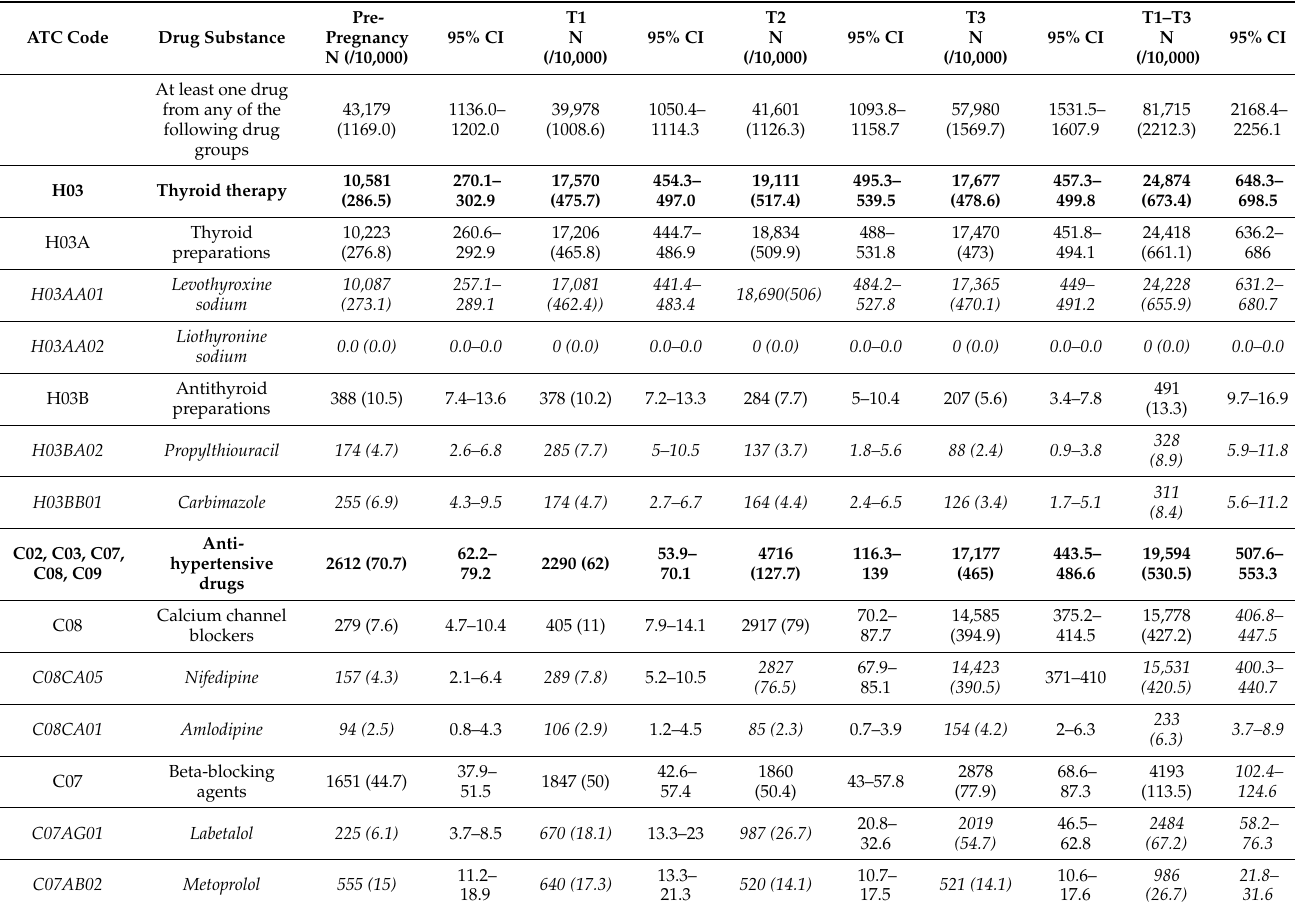
Table 2. Exposure prevalence to different drug groups and active substances during pregnancy overall and within trimester of pregnancy and pre-pregnancy separately (weighted